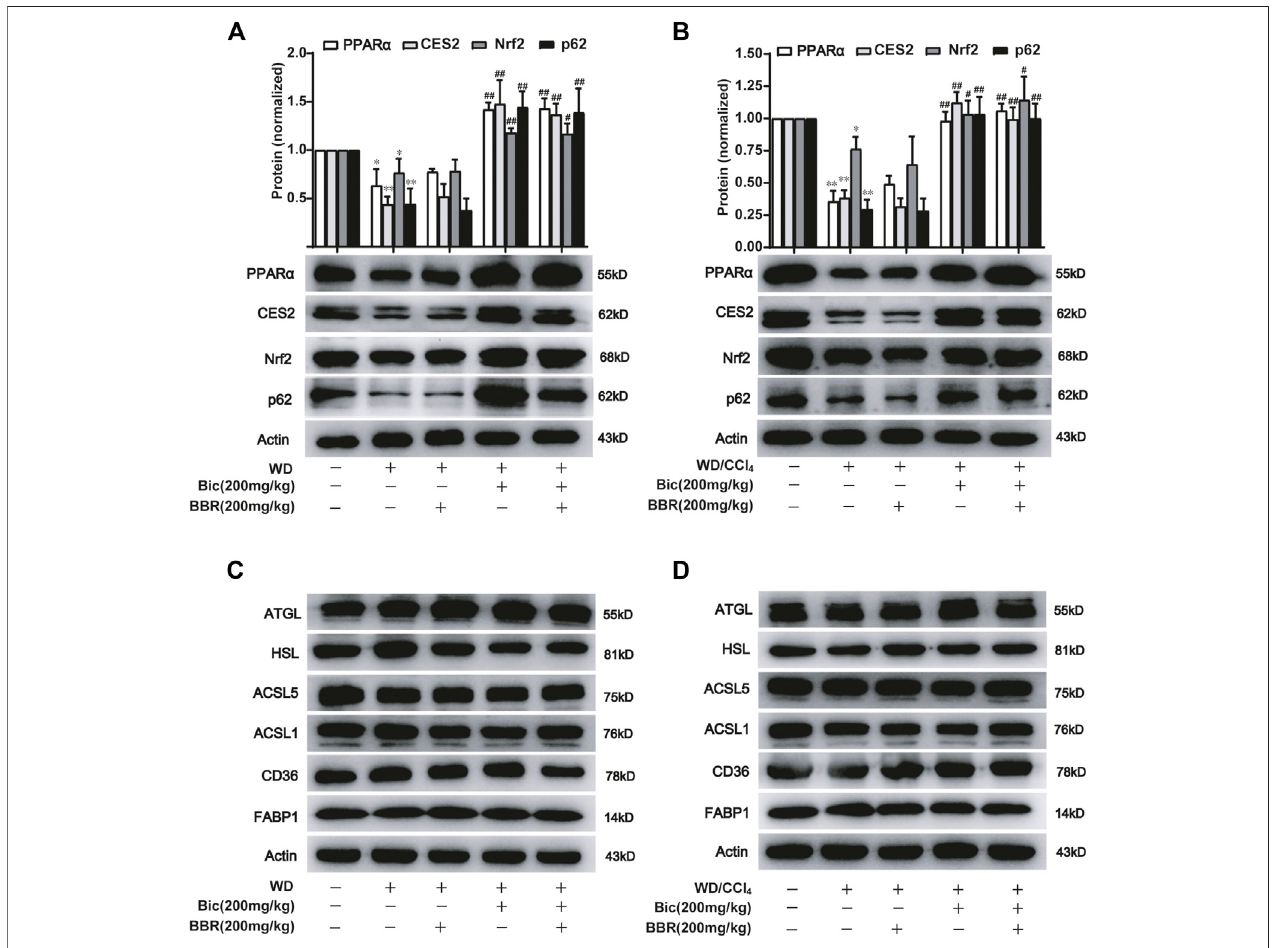
FIGURE 3 | Bicyclol with or without berberine enhances the lipolysis and β -oxidation through p62-Nrf2-CES2/PPAR α axis. Male C57BL/6J mice were freely fed withWDorWDplusbicycloland/orberberinefor16 weeks (A,C) ,orinducedwithWD/CCl 4 for4 weeksandthentreatedwithdrugsfor8 weeks (B,D) .Theproteinlevels of PPAR α , CES2, Nrf2, p62, CD36, FABP1, ATGL, HSL, ACSL1, and ACSL5 were detected with Western blot and quanti fi ed using a Gel-Pro analyzer. Results were presentedasmean±SD,andarepresentativebandwasshown.n=5 – 9foreachgroup,*p < 0.05and**p < 0.01,themodelgroupvs.controlgroup; # p < 0.05and ## p < 0.01 vs. the model group. PPAR α , proliferator-activated receptor α ; CES2, carboxylesterase 2; Nrf2, NF-E2-related factor 2; p62, ubiquitin-binding protein p62; CD36, cluster determinant 36; FABP1, fatty acid binding protein 1; ATGL, adipose triglyceride lipase; HSL, hormone-sensitive lipase; ACSL, acyl-CoA synthetase long chain family member.